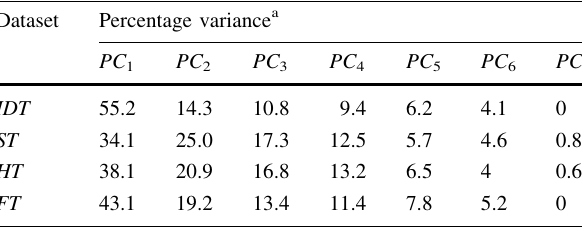
Table 2 Variance captured by the individual principal components (PCs) in respect of IDT, ST , HT and FT data sets Dataset